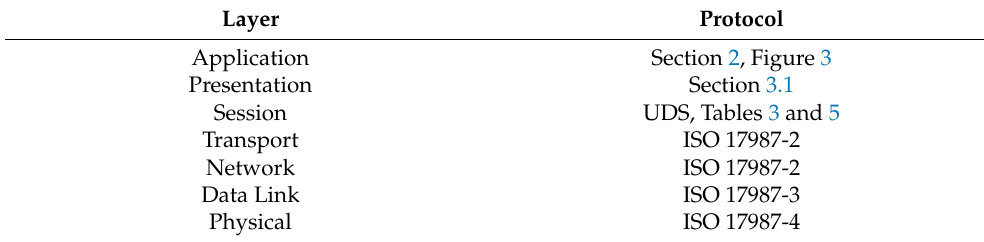
Table 6. OSI model of interconnection of the device and the concentrator by means of the LIN